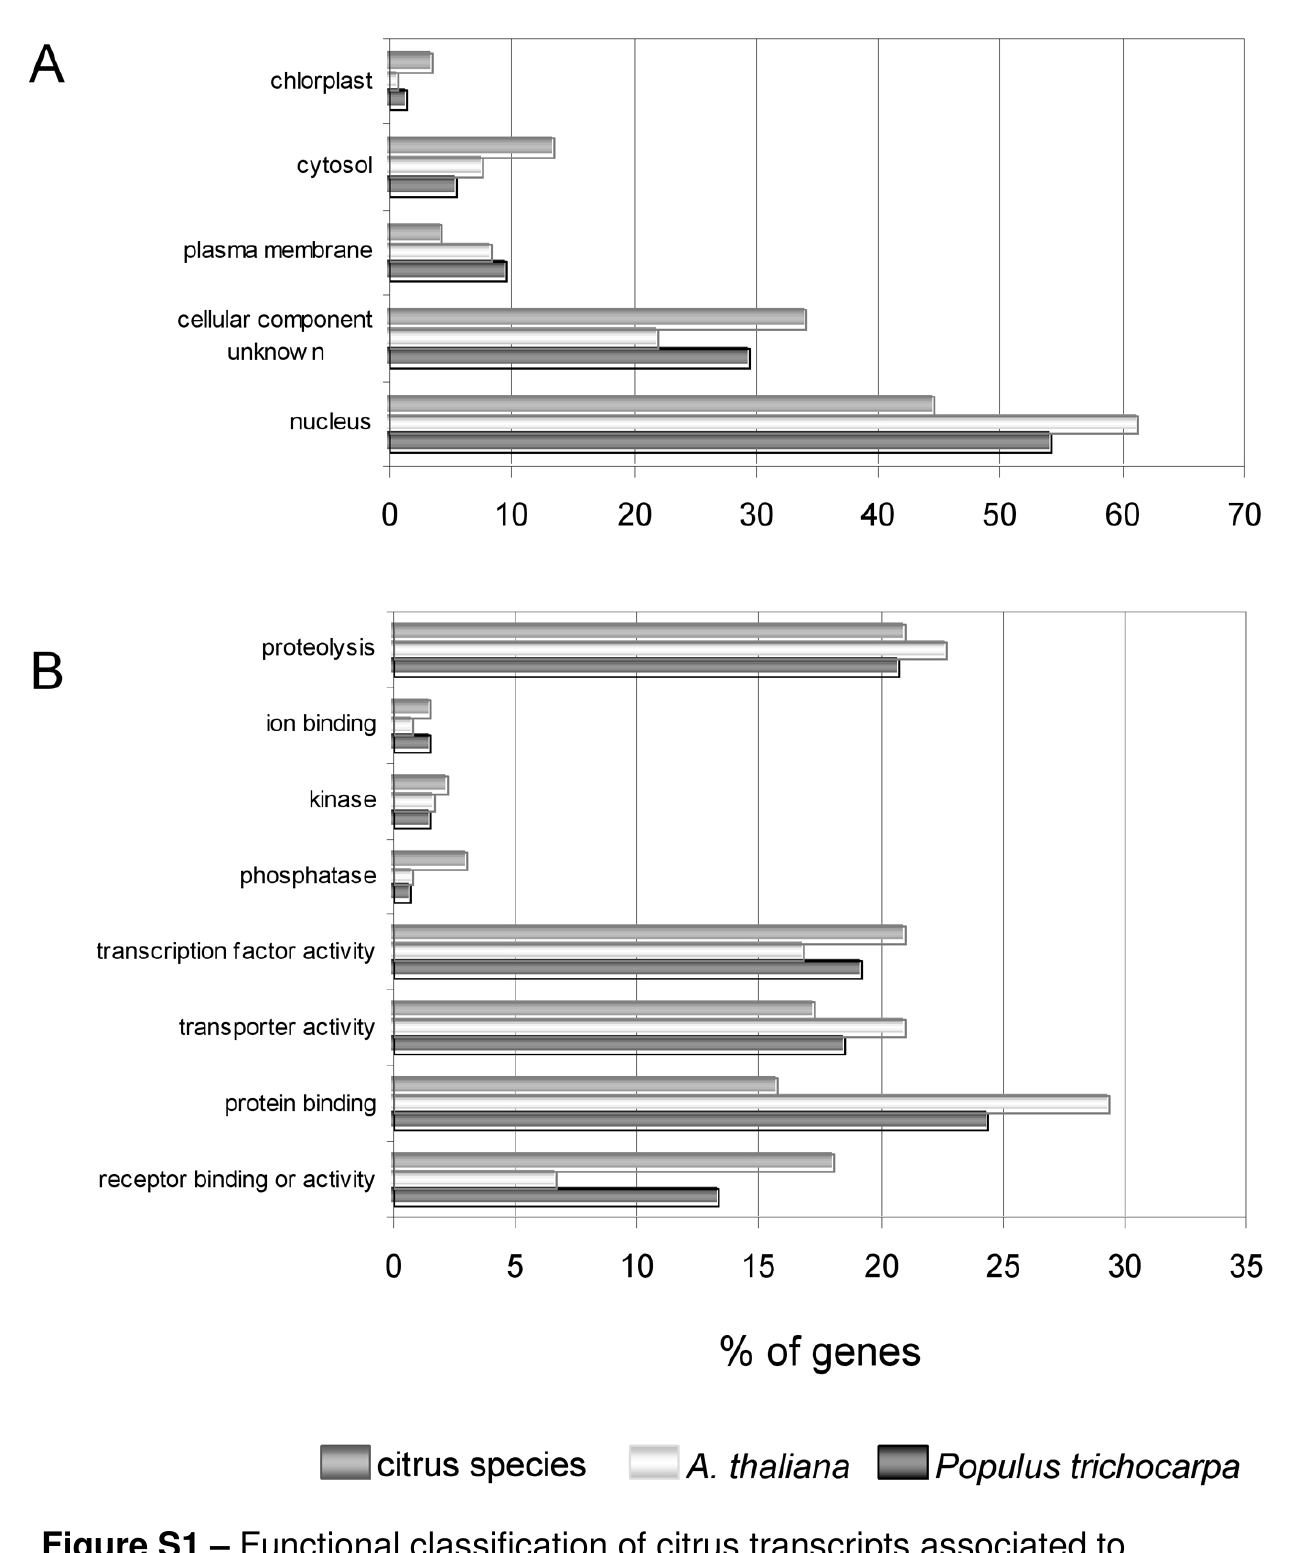
Figure S1 – Functional classification of citrus transcripts associated to photoperception and light signal transduction according to gene ontology (GO) categories in comparison to Populus trichocarpa transcriptome and Arabidopsis thaliana proteome. A. cellular component. B. molecular function. Assignments are based on the data available at the TIGR Arabidopsis thaliana Gene Index version